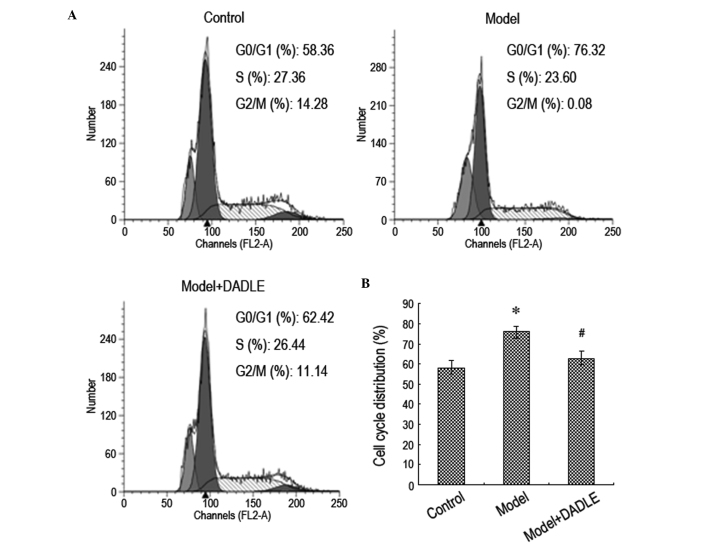
DADLE reverses ischemia/reperfusion-induced cell cycle arrest in intestinal epithelial cells. (A) Cell cycle analysis using flow cytometry. (B) Histogram of the cell cycle distribution of the intestinal epithelial cells, indicating the percentages of cells in the GO/G1 stage. *P<0.01, compared with the control group; and #P<0.05, compared with the model group. Each independent experimental group was repeated in triplicate. Data are presented as the mean ± standard deviation. DADLE, (D-Ala2, D-Leu5)-enkephalin; Model, ischemia/reperfusion.